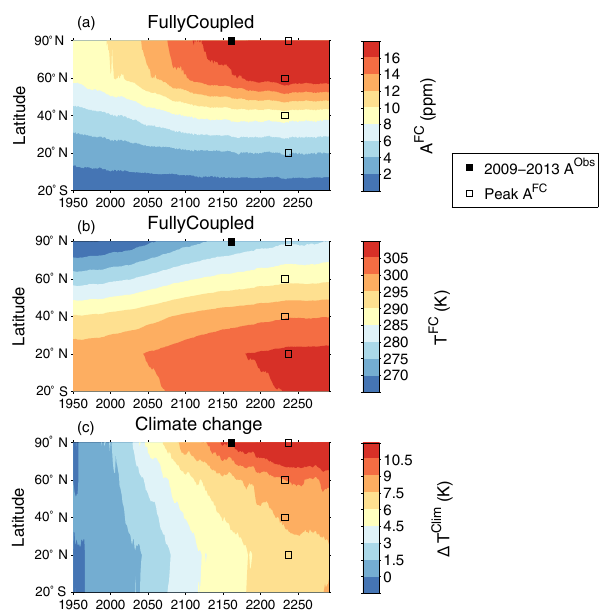
Figure 7. (a) From 1950–1959 to 2291–2300, 10-year moving averages of FullyCoupled atmospheric CO 2 annual cycle ampli- tude ( A FC ). The black square indicates the decade in which the CESM reached observed CO 2 annual cycle amplitudes averaged over 2009–2013 in the NH high latitudes (Table 4). Open squares indicate the decades when peak amplitudes occurred. In the NH midlatitudes, subtropics, and tropics, peak amplitudes did not reach present observed values. (b) Atmospheric temperatures over land in the FullyCoupled simulation ( T FC ). (c) The change in atmospheric temperature with respect to the 1950–1959 mean caused by climate change ( (cid:49)T Clim ).